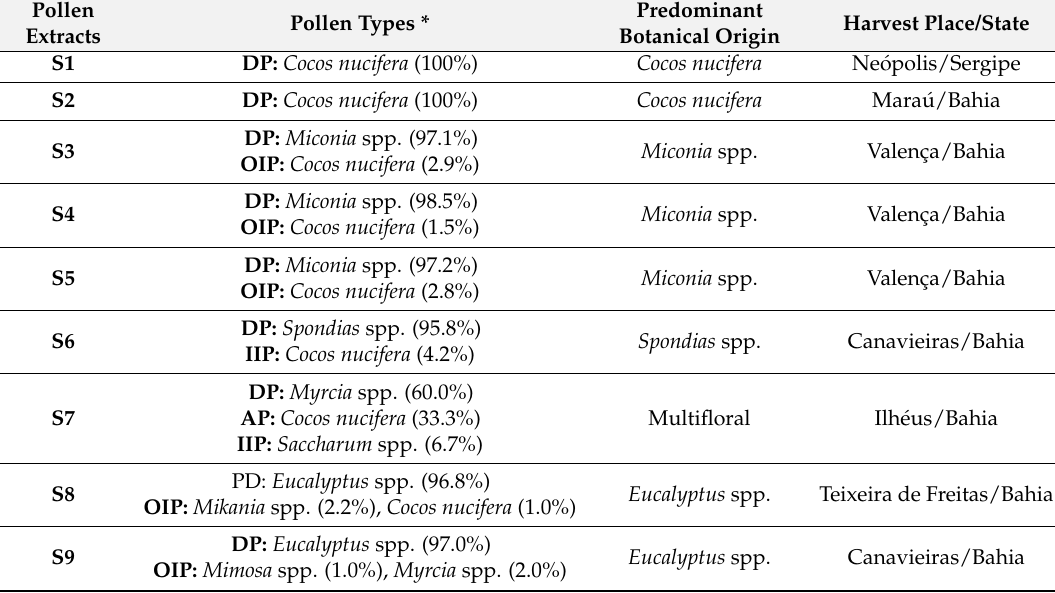
Table 4. Pollen types identified in samples of A. mellifera , and predominant botanical origin and harvesting